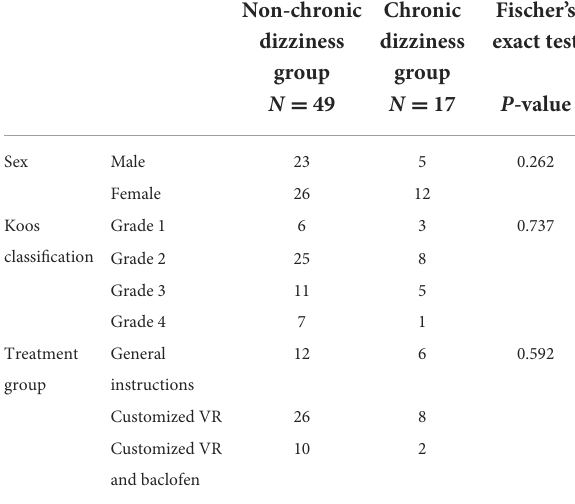
TABLE 2 Comparison of categorical variables between chronic dizziness and non-chronic dizziness